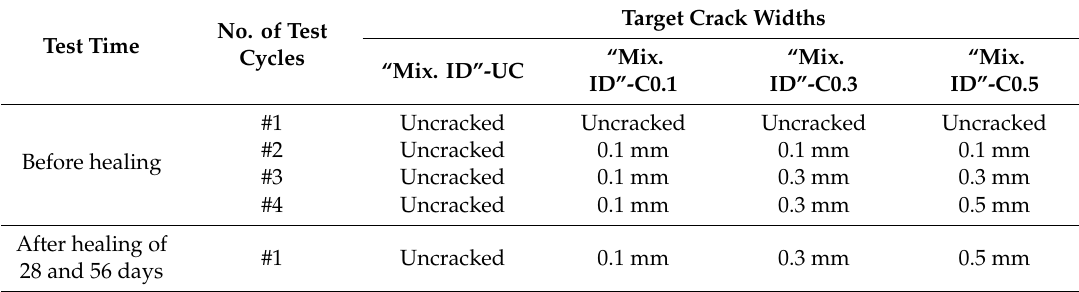
Table 1. Details of target crack widths in the second-phase tests.